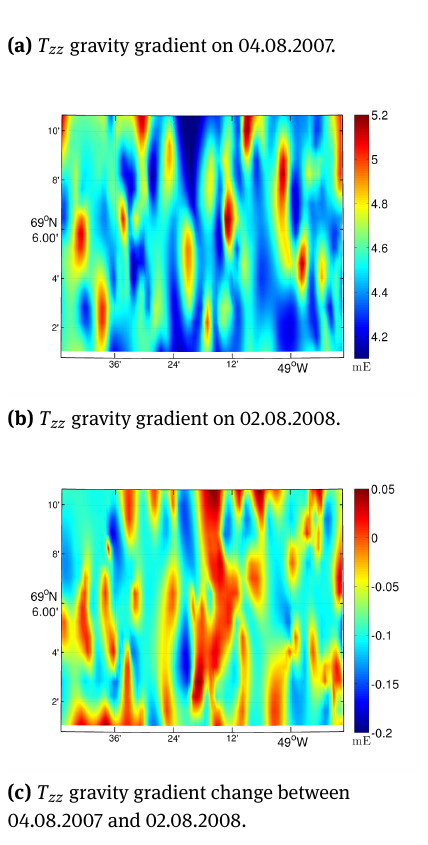
Fig. 10. JI T zz gravity gradients at satellite altitude for the two differ- ent time intervals, (a) and (b), and the change between the two (c) due to the mass change. The given units are E ¨ o tv ¨ o s